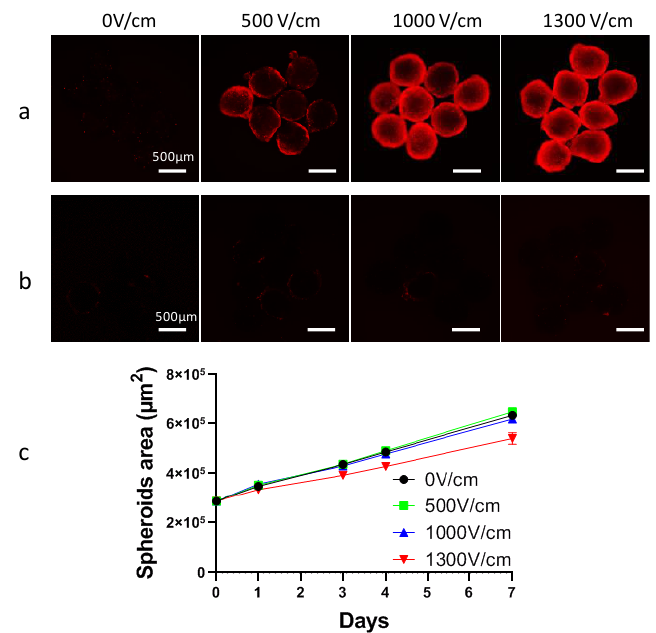
Figure A1. Determination of optimal voltage for HCT-116 spheroid’s electropermeabilization. ( a ) Cell electropermeabilization within the spheroid was globally assessed by propidium iodide (PI) penetration. For that purpose, at least 6 spheroids were submitted to an external electric field (8 pulses lasting 100 µ s at 1 Hz frequency) with increasing intensity in pulsation bu ff er supplemented with 100 µ m PI. PI fluorescence was recorded immediately after electroporation using an AxioObserver wide field fluorescence microscope (Zeiss, Marly-le-roi, France). ( b ) Plasma membrane resealing, ensuring that electroporation was reversible, was tested by incubating at least 6 spheroids with 100 µ M PI 30 min after electroporation application. ( c ) Tumor spheroid growth curves were recorded over 7 days after application of electroporation with increasing electric field strength. Fixed number ( × 8), frequency (1 Hz), and duration (100 µ s) of pulses were used; solely electric field intensity was modified in this experiment. Further, 1000 V / cm and 1300 V / cm conditions, respectively used in [9] and [14] induced an e ffi cient cell electropermeabilization, which was not the case for 500 V / cm condition ( a ). None of these three voltages induced irreversible electropermeabilization since no permeabilized cells were observed 30 min after electroporation ( b ). Finally, the following growth of the spheroid indicated that 1300 V / cm significantly alter spheroids’ growth, explaining why we chose 1000 V / cm